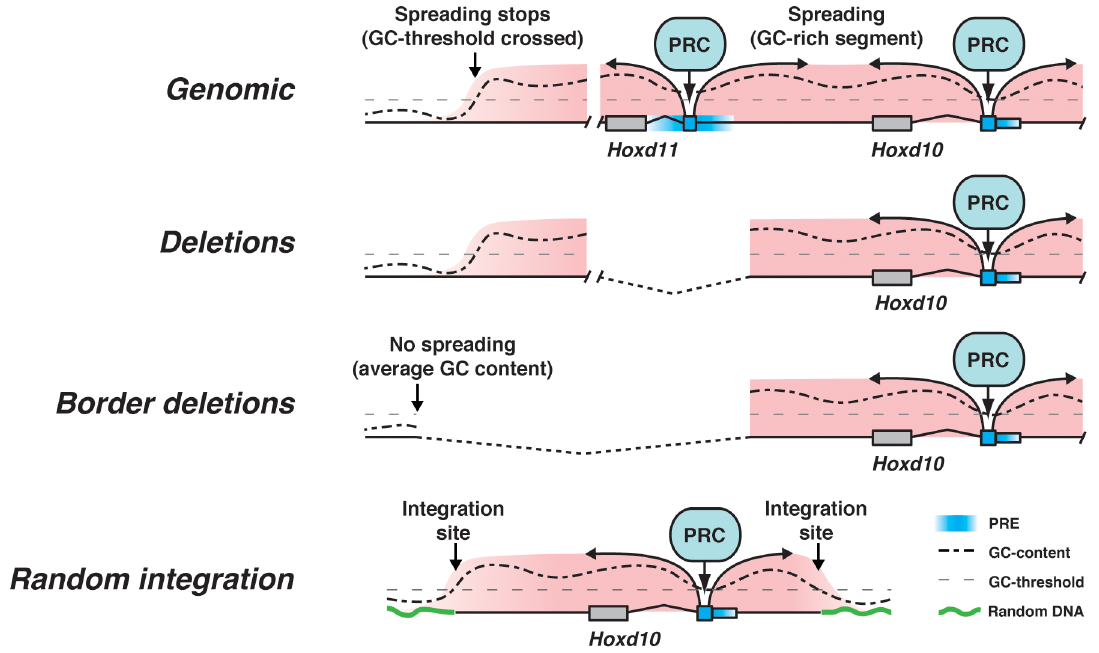
Figure 6. A model for PRC2 recruitment. In a first phase, PRC2 is tethered to a particular combination of low affinity PREs. Once bound, the surrounding GC density becomes important for stabilizing or strengthening the binding to target DNA. Internal deletions do not alter the general landscape. Deletion of the borders of the epigenetic domain do not lead to PcG leakage due to the translocation of the 3 9 breakpoint into sequences of low or average GC density. Similar results are observed when transgenic constructs are introduced randomly into the